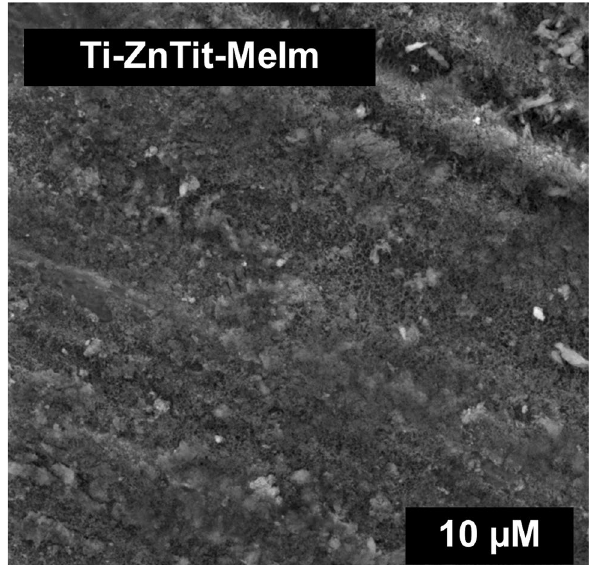
Figure 10. SEM image of Ti-ZnTit-MeIm.